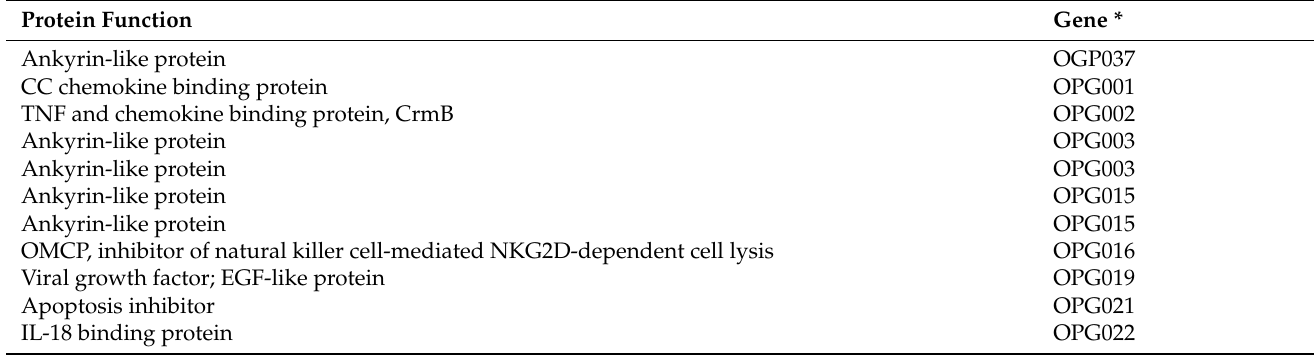
Table 1. Immune evasion genes of the mpox